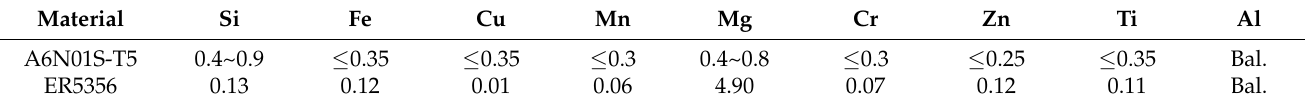
Figure 1. Schematic diagram of groove type for arc-welded aluminum alloy profiles. Table 1. Chemical composition of the base material and filler wire (wt.%).